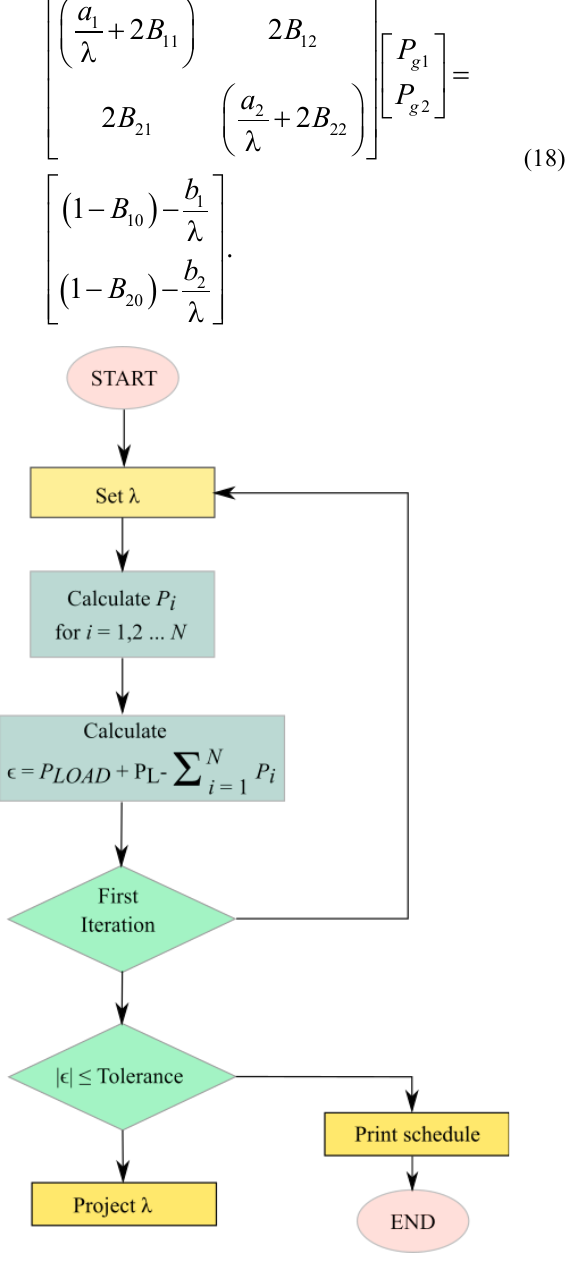
Fig. 3. Flowchart of Lambda iteration